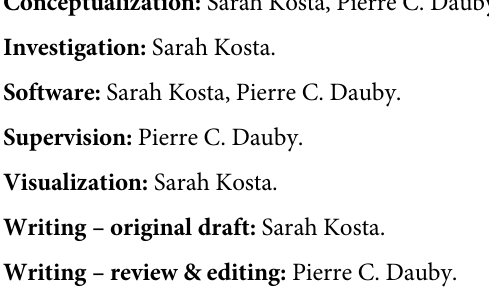
Table B. Mechanical parameters. Table C. Hemodynamic parameters. Table D: Standard val- ues of hemodynamic quantities corresponding to a healthy subject that are used in the 13-parameter identification procedure. Table E. Standard values of hemodynamic quantities corresponding to a healthy subject that are used in the 9-parameter identification procedure. S2 Appendix. Analysis of the time evolution of the system during an IIP protocol. Fig A. Cellular variables during a heartbeat in the baseline case (solid blue), during an IIP protocol (solid red), and during an IIP protocol with NO LDA (dashed red). Vertical bars indicate intervals for the four phases of the cardiac